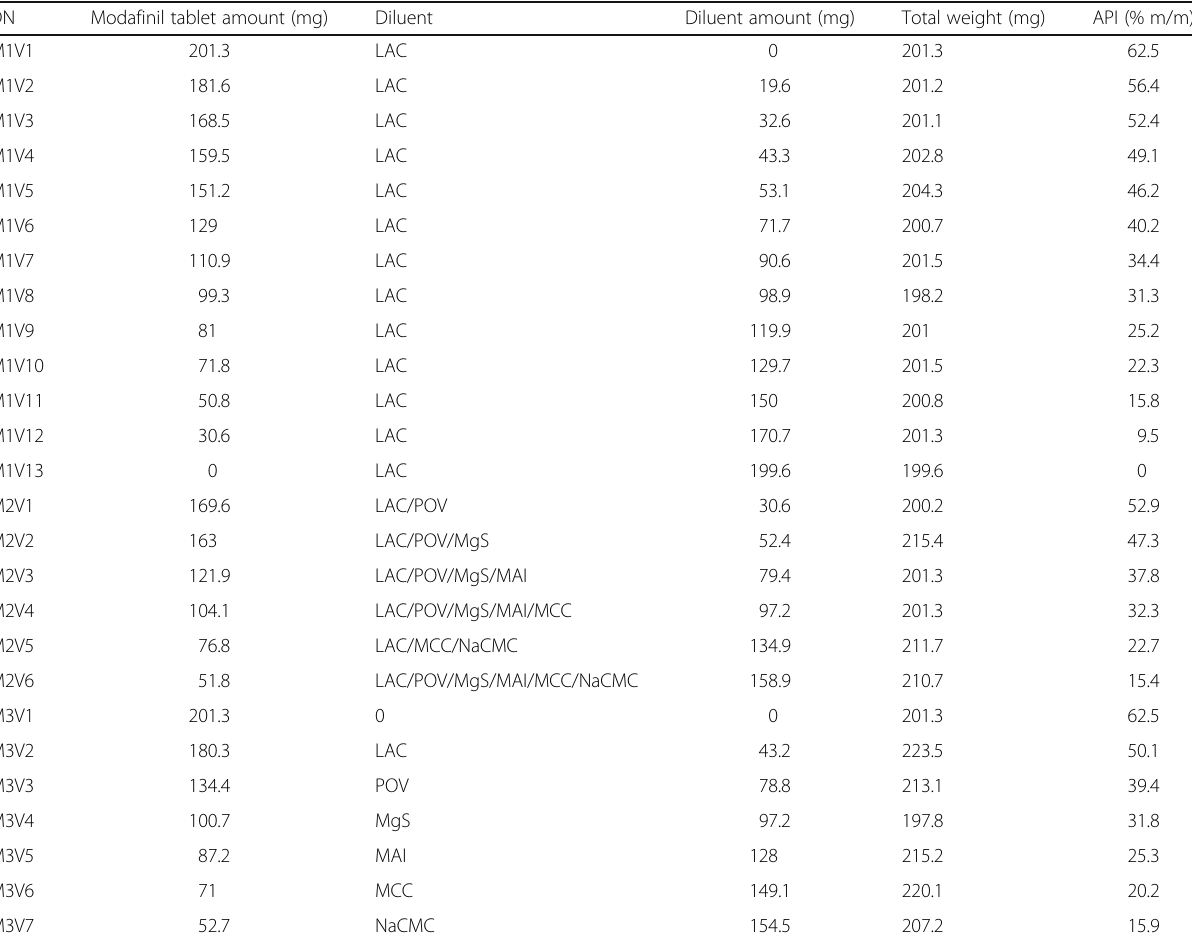
Table 2 Details of the powdered mixtures prepared